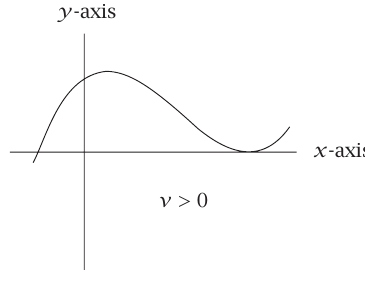
Figure 5.3 . The graph of g